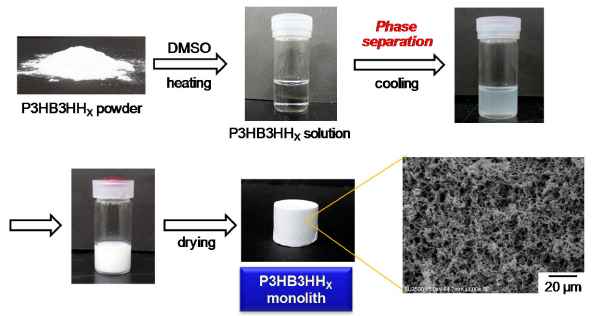
Figure 1. General procedure for fabrication of P3HB3HH x monolith.